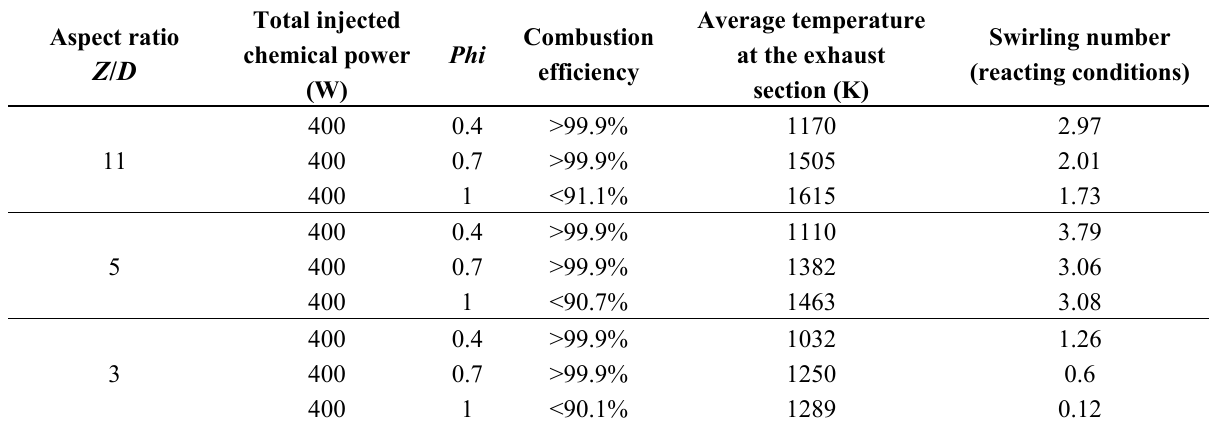
Table 3. Overall results of the 9